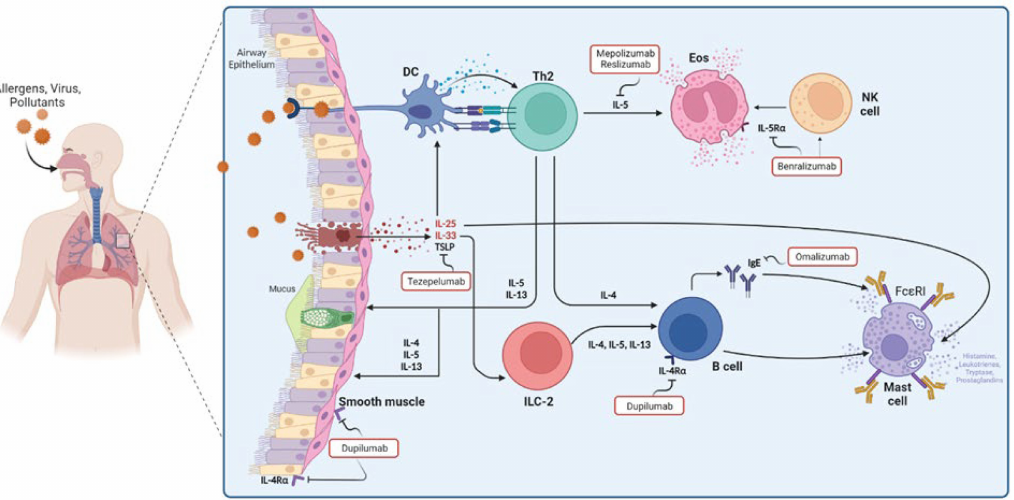
Figure 1. Cells, cytokines, and mediators involved in asthma pathophysiology and the mechanisms of targeted therapy that have been approved in